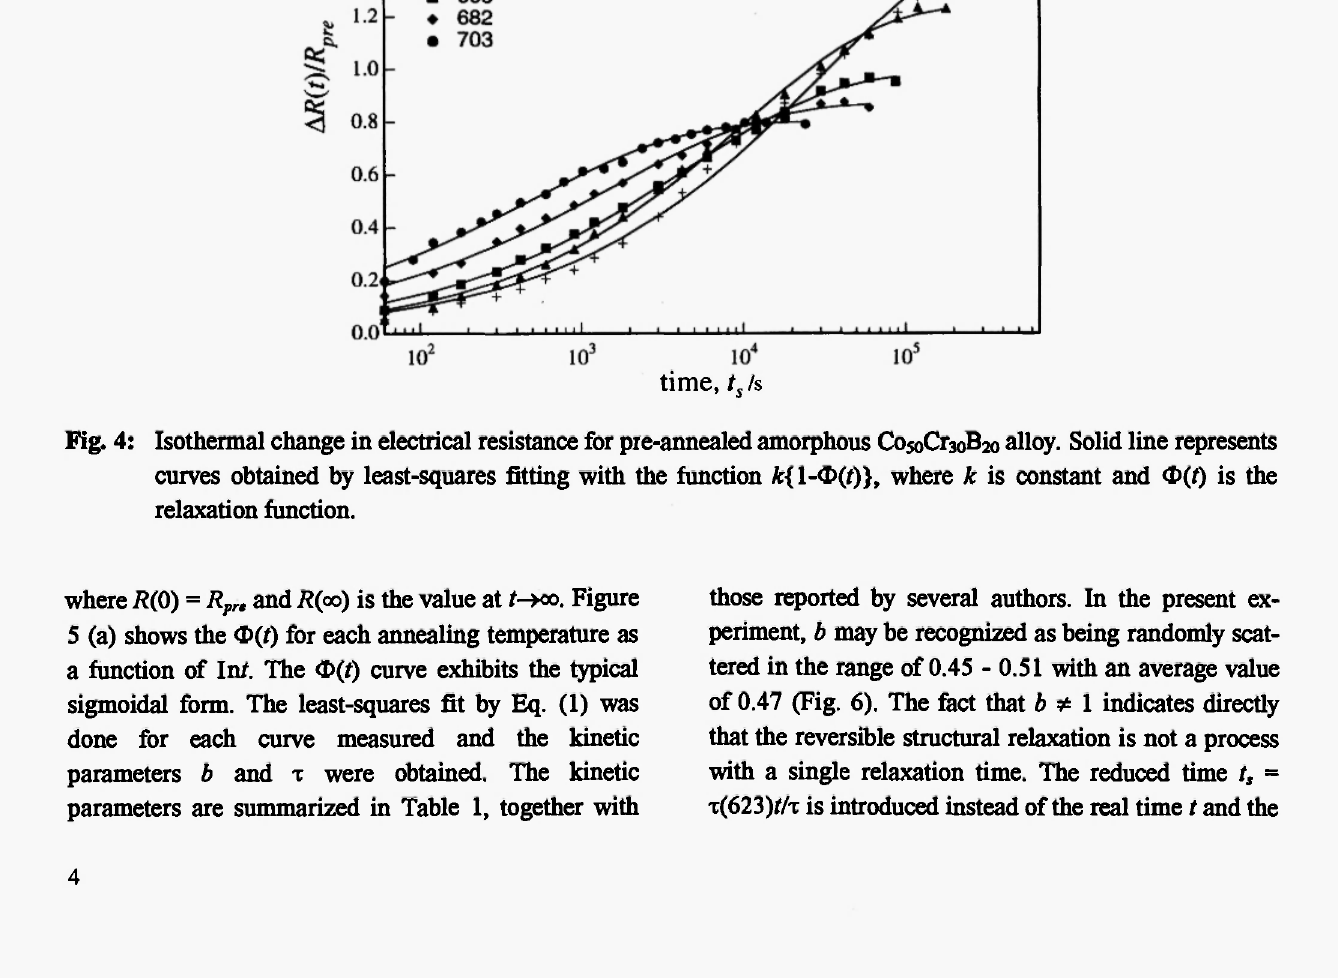
alloy. Solid line represents 2 O